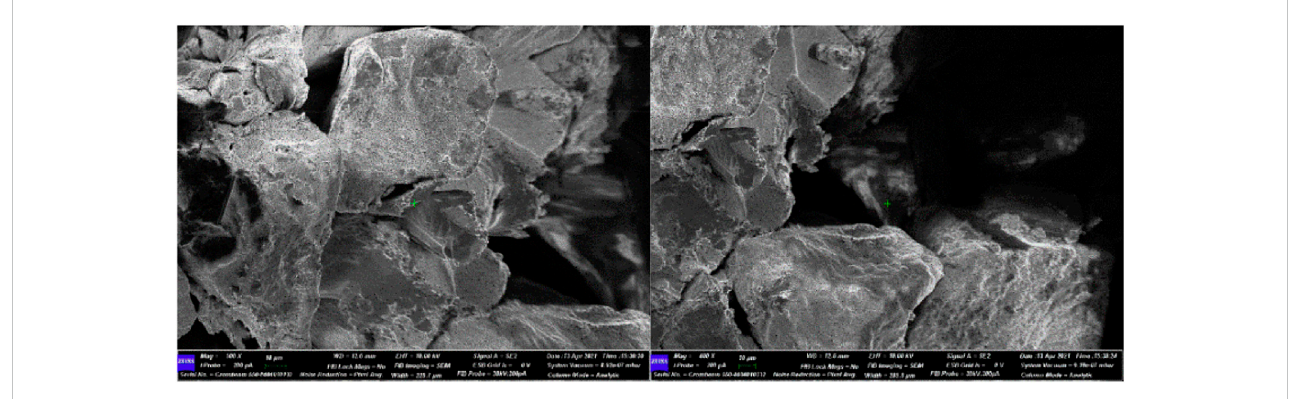
FIGURE 4 Pictures of cores scanning electron microscope.